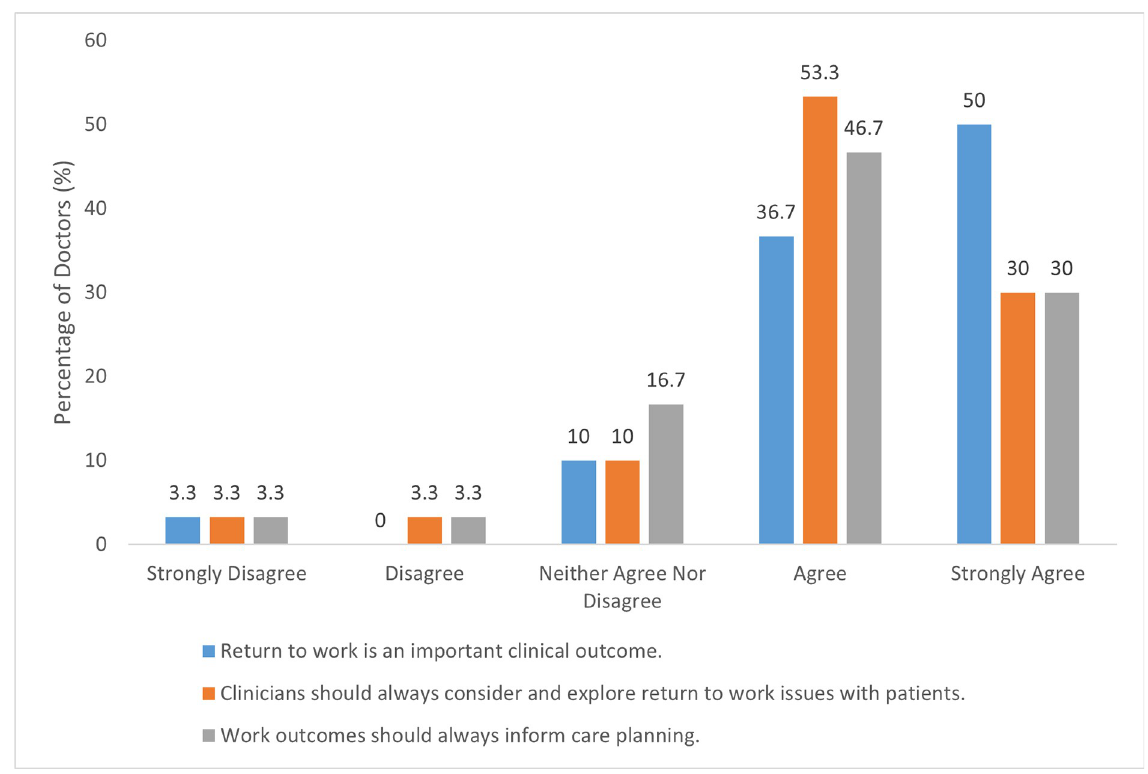
Fig 2. Ophthalmologists’ attitudes to return to work as a clinical